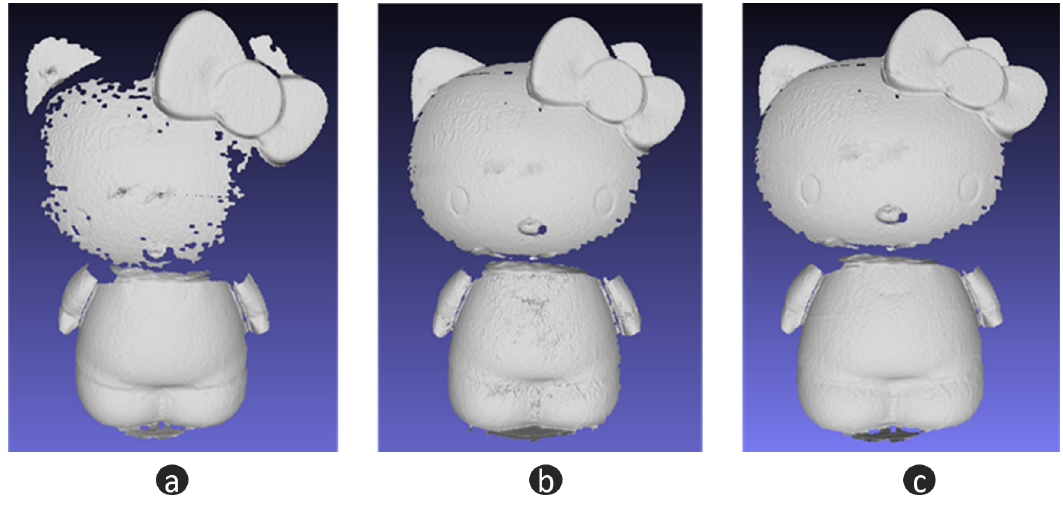
Figure 10. 3D reconstruction results. ( a ) reconstructing from FPP; ( b ) reconstructing from laser stripe scanning (LSS); ( c ) fusion results.